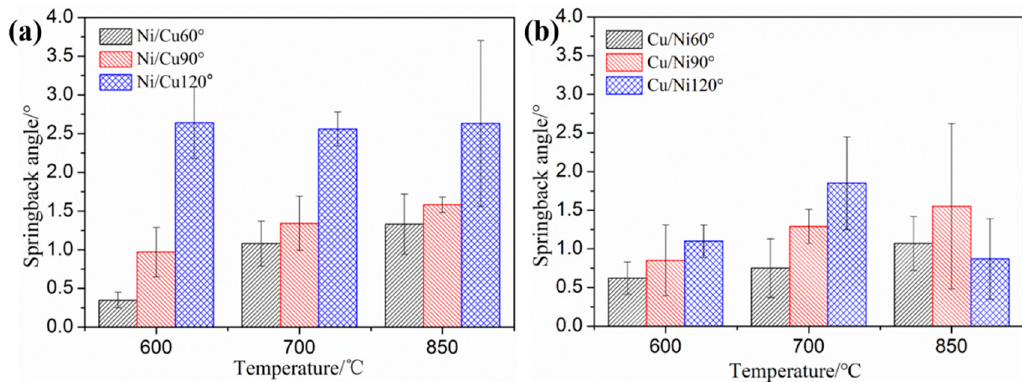
Figure 9. Springback angle for specimen under di ff erent annealing temperature ( a ) Ni / Cu and ( b ) Cu / Ni.